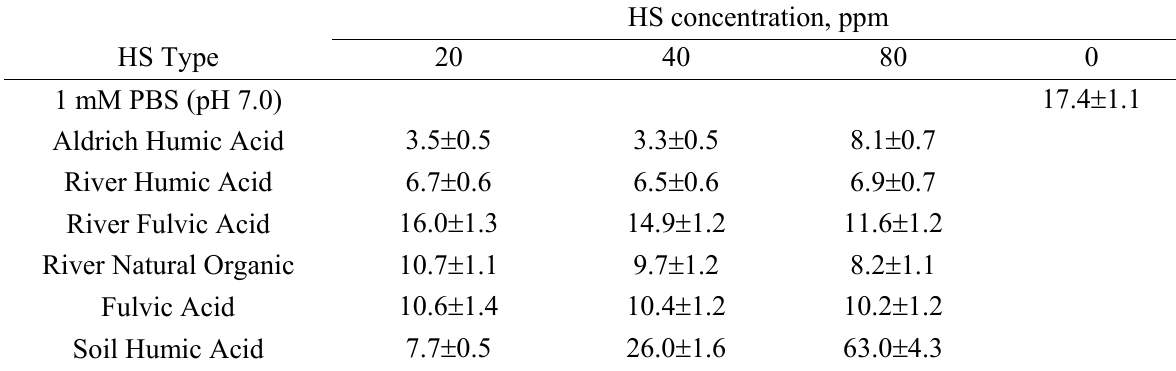
, min) in commercial HS buffer solutions under UVA 1/2